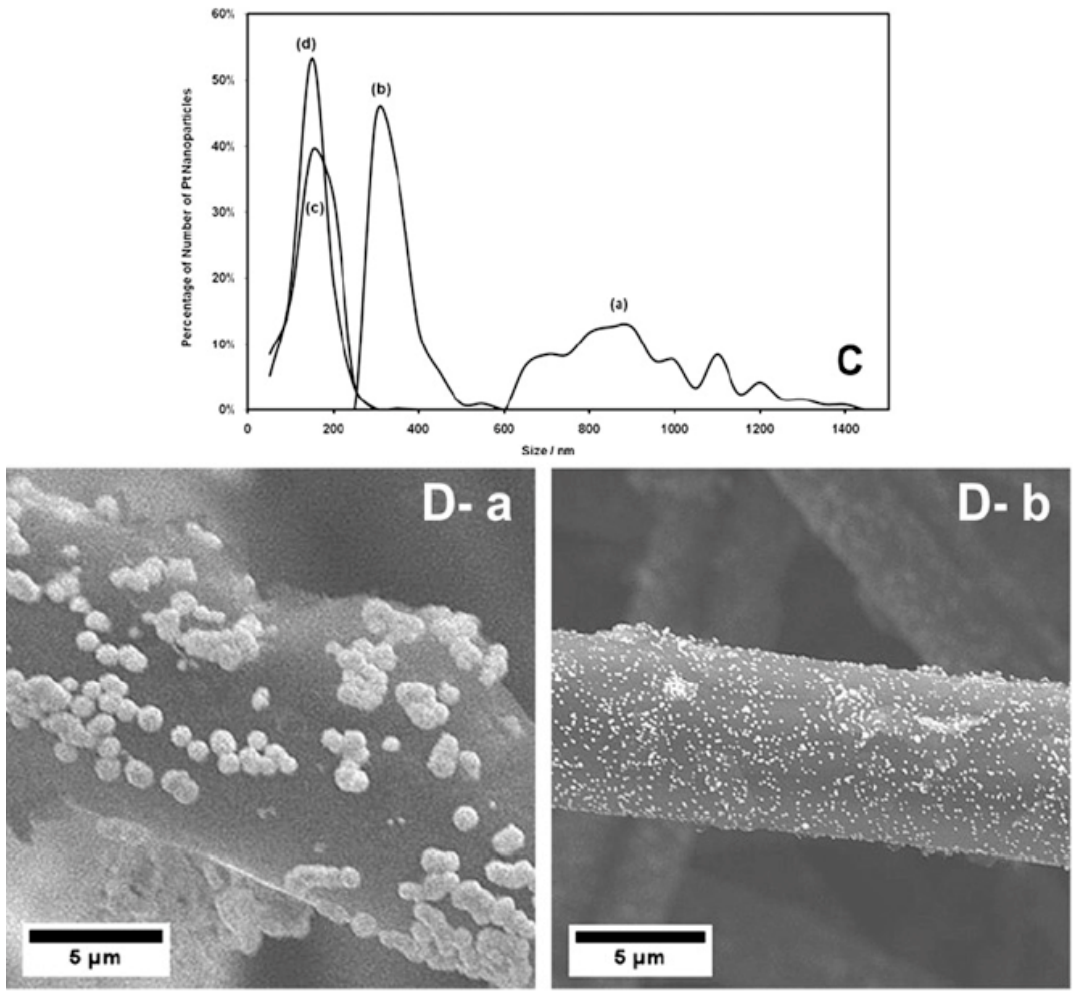
Figure 19. ( C ) Particle size distribution curves: (a) no ultrasound, (b) 2.3 W, (c) 3.2 W, and (d) 4.4 W. ( D ) SEM pictures of Pt electrodeposited on GDL (a) under silent and (b) ultrasonic (4.4 W) conditions [28].